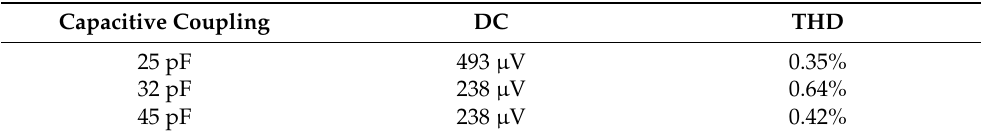
Table 4. Output voltage harmonic content.